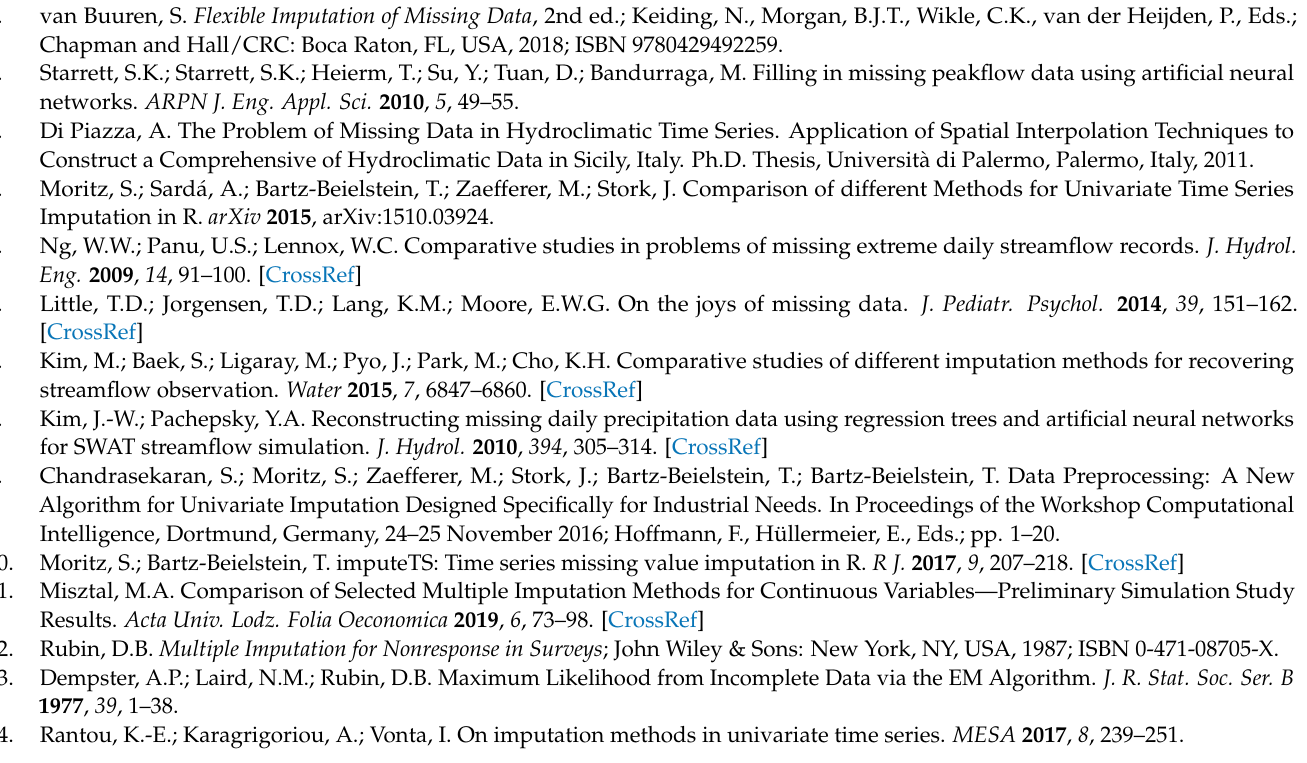
watershed. Figure S2. Distribution curve of the (a) complete and (b) transformed streamflow dataset of the Maduwang watershed. Figure S3. Time series decomposition of (a) complete and (b) transformed Maduwang dataset. Figure S4. Autocorrelation of (a) complete and (b) transformed Maduwang dataset. Figure S5. Results of (a) time series decomposition and (b) autocorrelation of the Zhidan